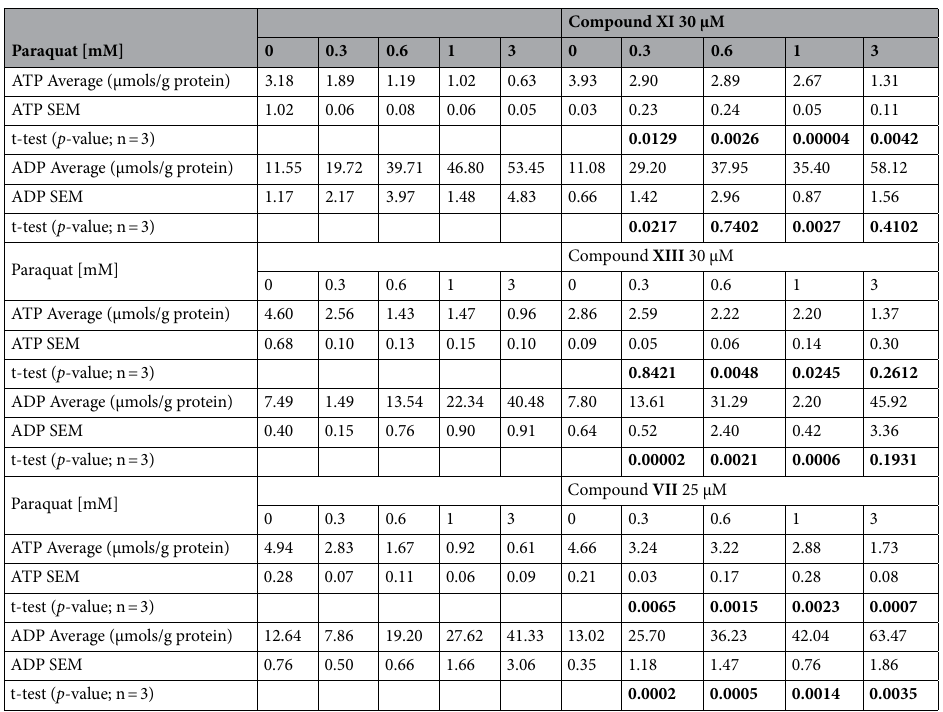
Table 1. Effects of OGG1 activation on paraquat-induced changes in energy metabolites. A549 cells were cultured as described in Methods. Compounds were added to the cells 4 h prior to paraquat and were incubated for an additional 48 h prior to lysis for measurement of metabolites. Datarepresents mean ± S.E.M (N = 3 experiments with triplicate measurements). Statistical comparisons were made using an unpaired, two- tailed t-test between cells plus or minus paraquat. The p- values (significance) are in